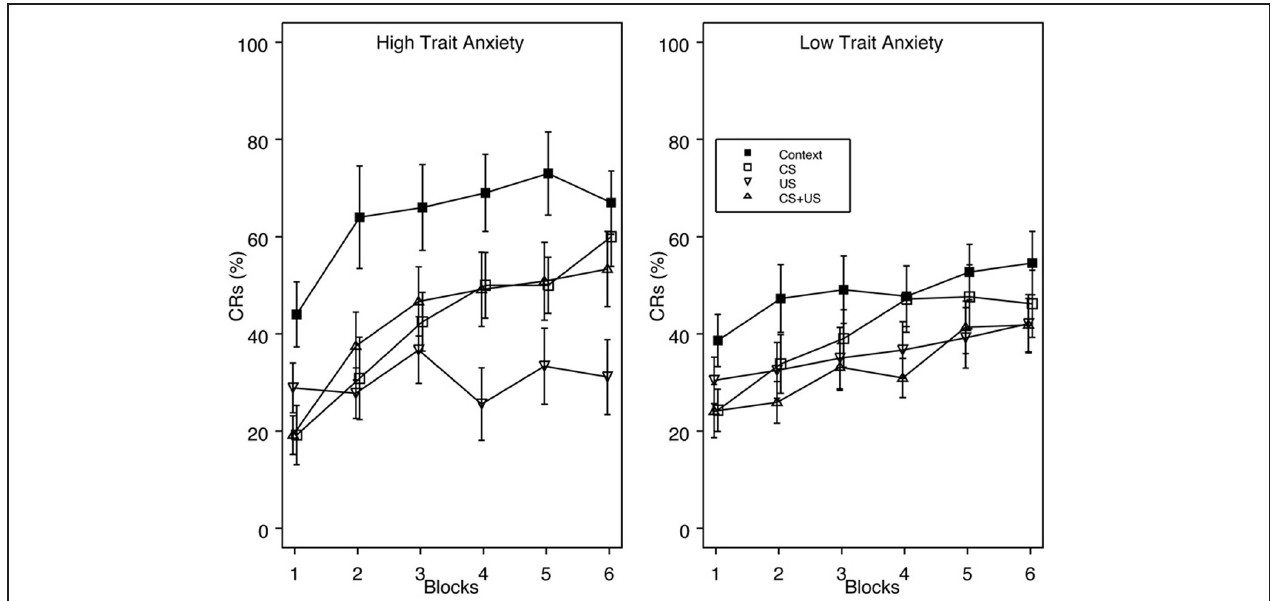
significant interaction of Vulnerability × Block, with faster CR acquisition for vulnerable individuals over the training session. High trait anxious individuals also demonstrated greater proactive interference than low trait anxious individuals. The legend indicating pre-exposure condition is contained within the right panel. Error bars represent the standard error of the